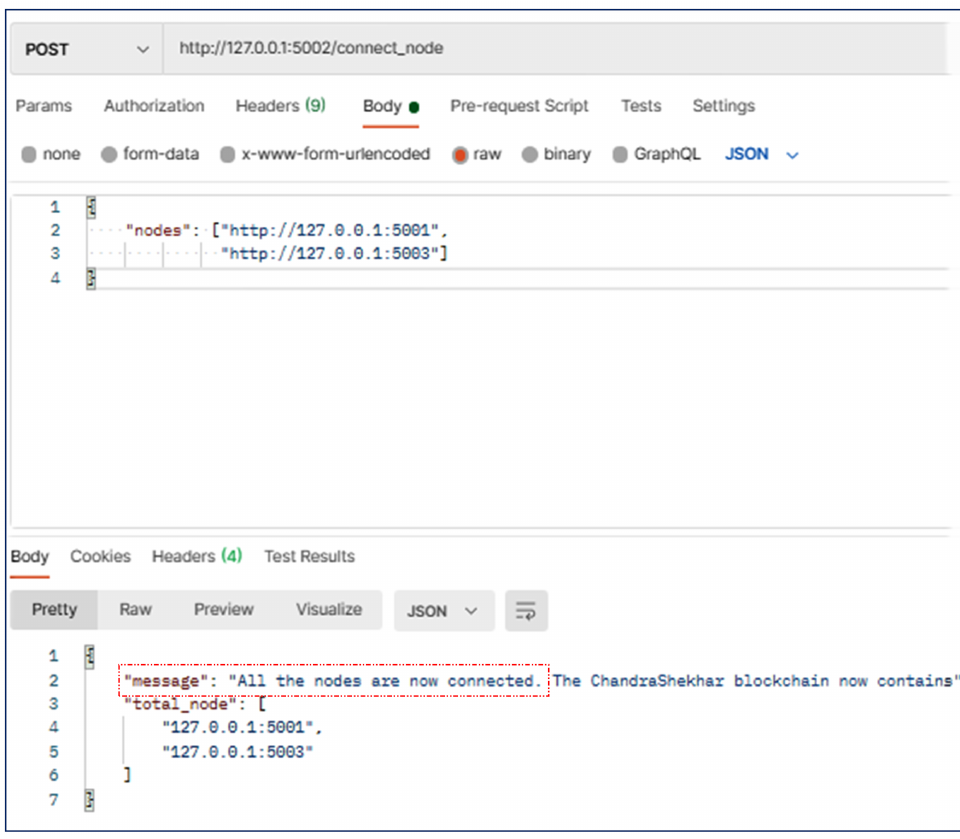
Figure A1. Node connecting using POST request.